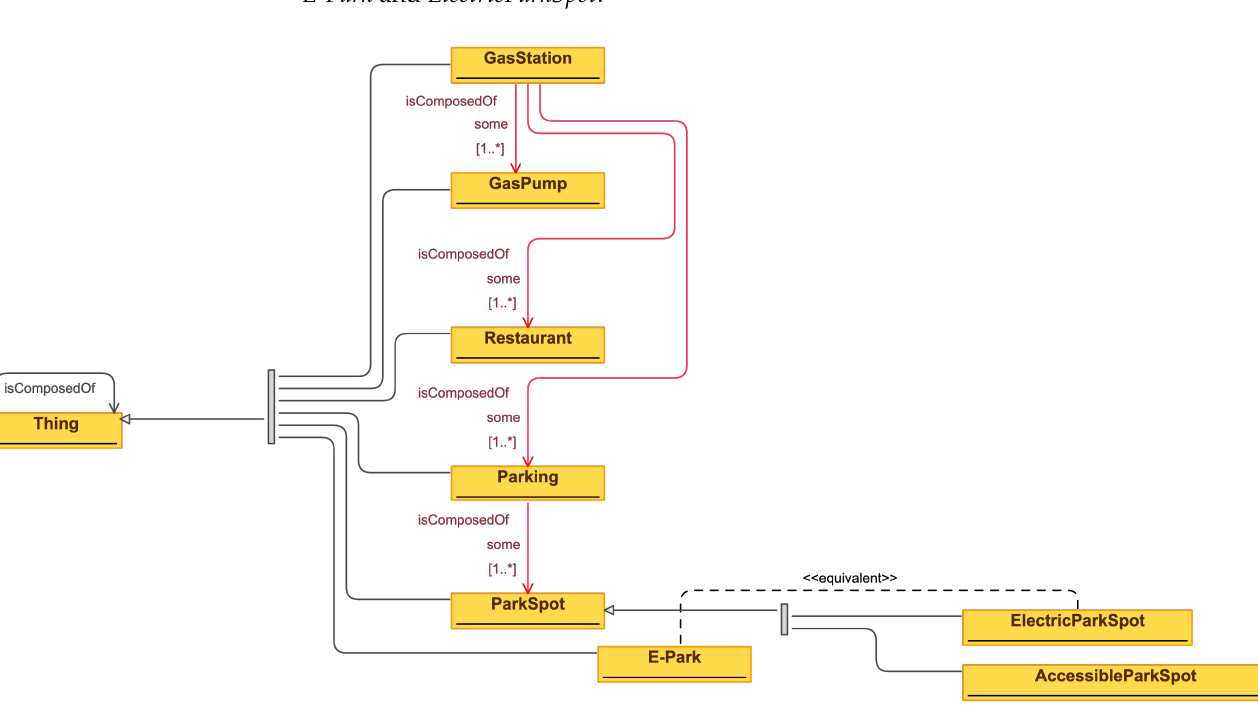
Figure 5. A taxonomy of concepts related to a generic Gas